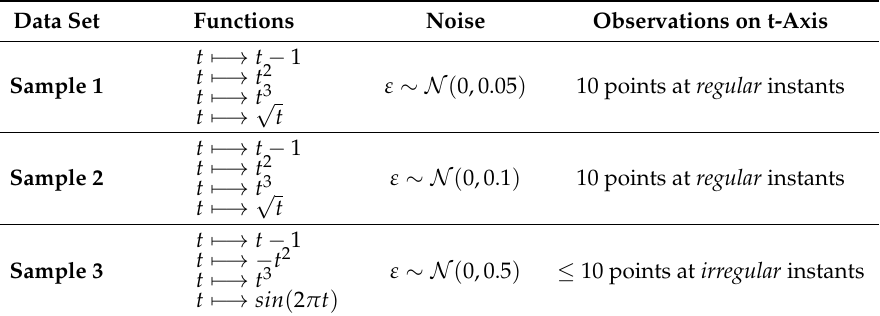
Table 1. Details on the simulated samples. Processes are defined as f ( t ) + ε with four different functions f in each sample and a varying noise parameter (cid:101)